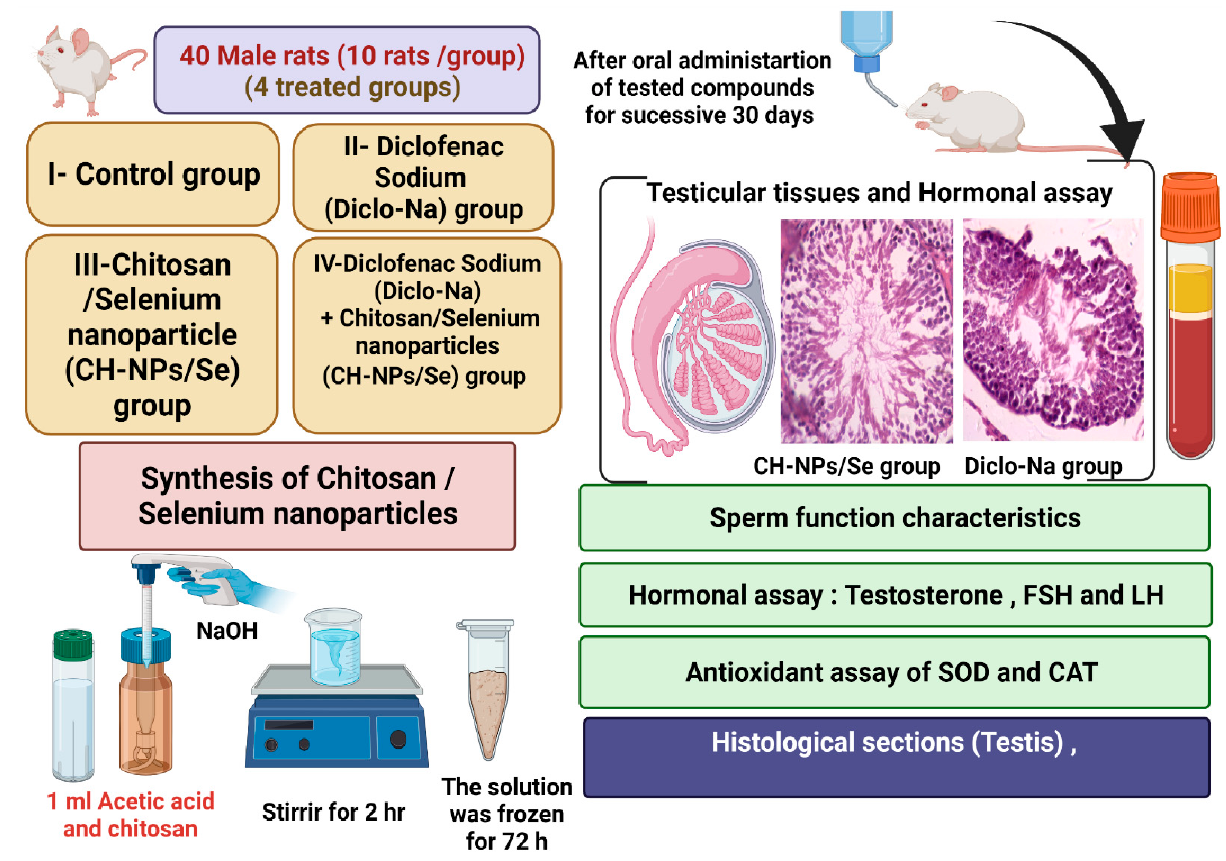
Figure 1. Experimental protocol.